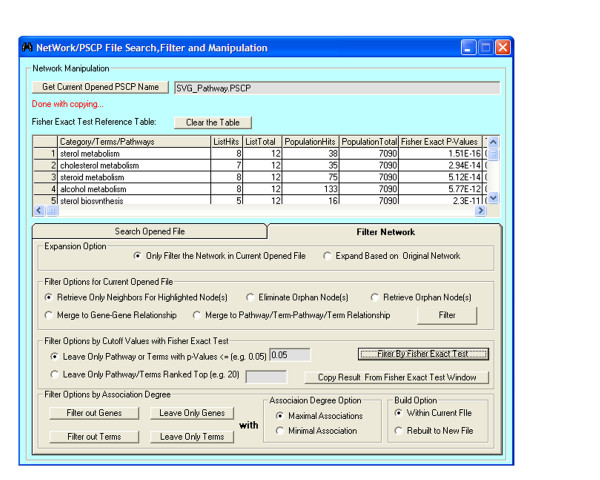
Window for GTAN filtering and manipulation. Many filtering options are available including Filtering by Fisher's exact test result, by association degree, and by retrieving neighbors for highlighted nodes, merging to gene-gene or term-term network, and disease-associated gene highlight feature.